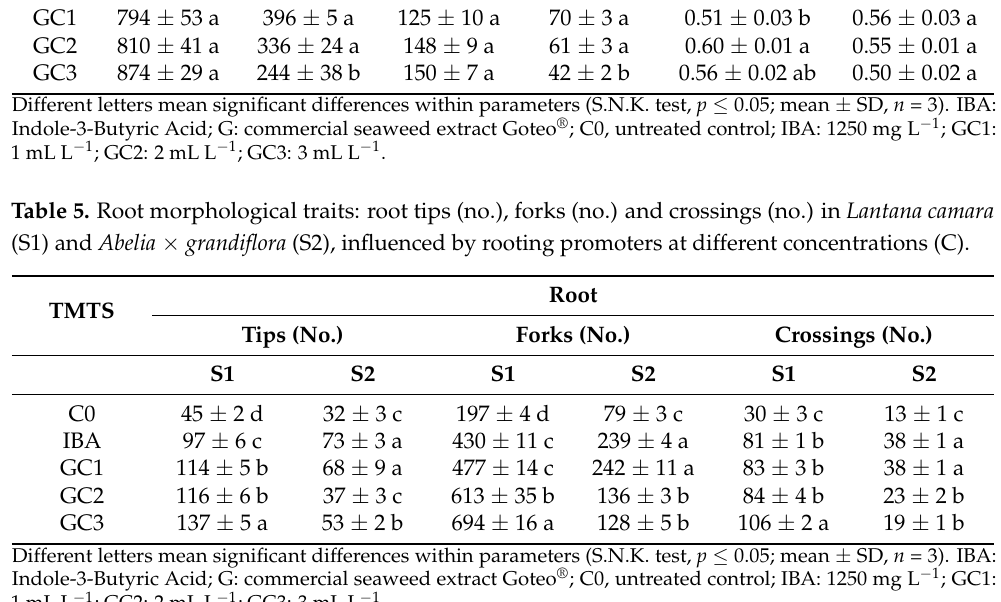
Table 4. Root morphological traits: root length (mm), root surface area (mm 2 ) and average root diameter (mm) in Lantana camara (S1) and Abelia × grandiflora (S2), influenced by rooting promoters at different concentrations (C). Root TMTS Length (mm) Surface Area (mm 2 ) Diameter (mm) S1 S2 S1 S2 S1 S2 C0 370 ± 23 c 166 ± 16 b 60 ± 5 c 25 ± 3 c 0.52 ± 0.01 b 0.48 ± 0.03 a IBA 649 ± 38 b 391 ± 5 a 96 ± 6 b 67 ± 5 a 0.49 ± 0.02 b 0.52 ± 0.06 a GC1 794 ± 53 a 396 ± 5 a 125 ± 10 a 70 ± 3 a 0.51 ± 0.03 b 0.56 ± 0.03 a GC2 810 ± 41 a 336 ± 24 a 148 ± 9 a 61 ± 3 a 0.60 ± 0.01 a 0.55 ± 0.01 a GC3 874 ± 29 a 244 ± 38 b 150 ± 7 a 42 ± 2 b 0.56 ± 0.02 ab 0.50 ± 0.02 a